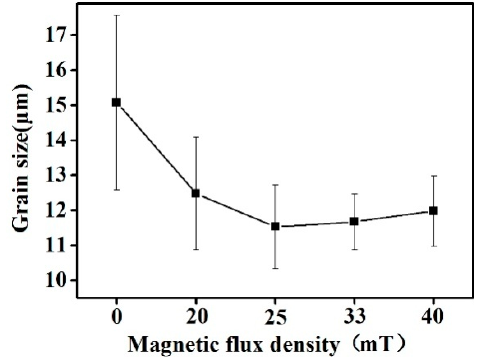
Figure 4 . The average Fe grain size with various magnetic flux densities. Figure 4. The average Fe grain size with various magnetic flux